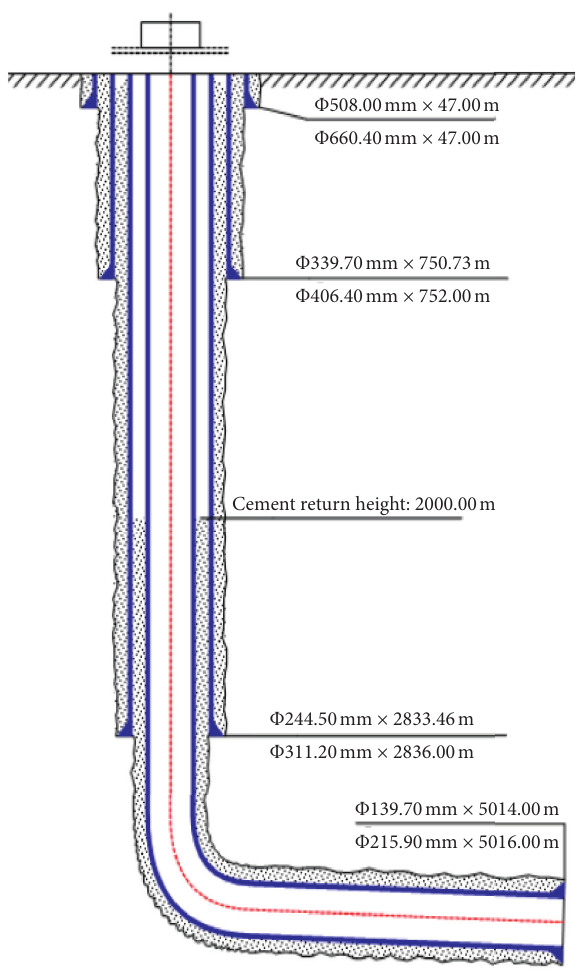
Figure 6: Casing program of horizontal